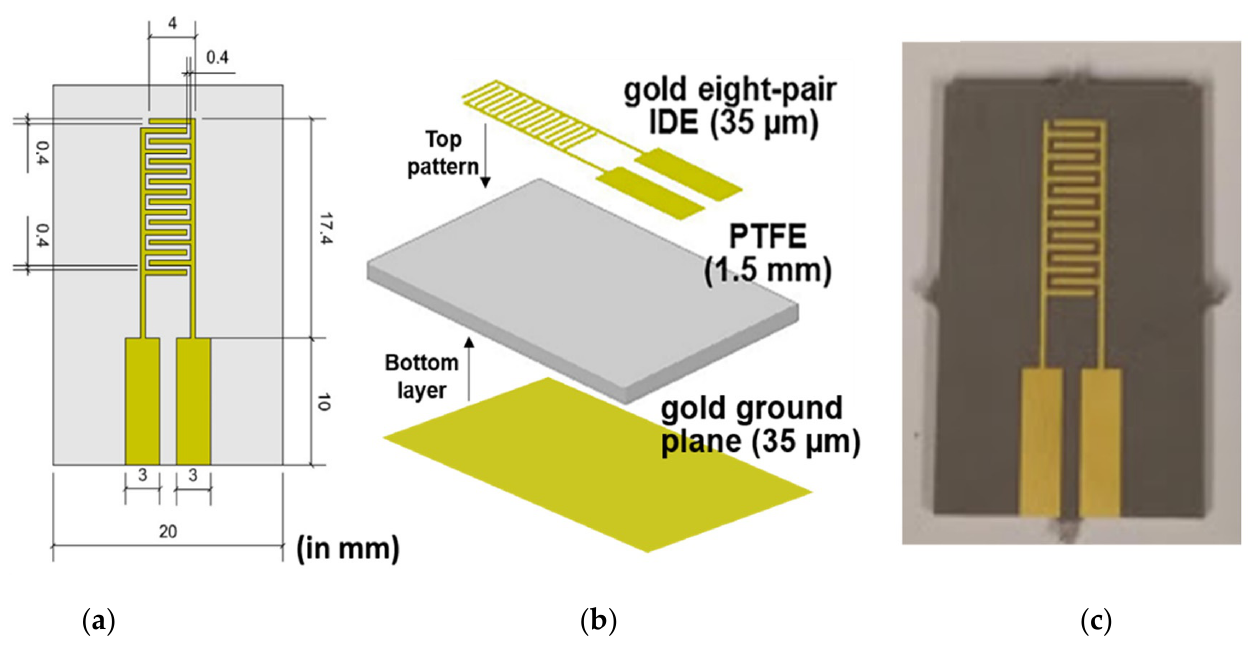
Figure 5. ( a ) Scheme with size of an Au eight-pair IDE sensor (mm) showing its front view, ( b ) 3D view and ( c ) a picture of it.